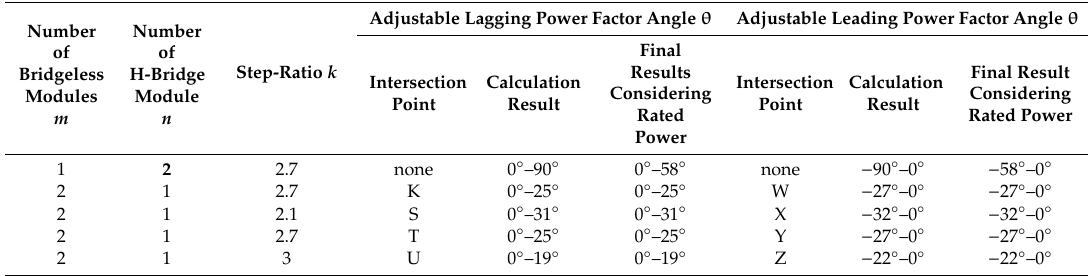
Figure 5. AC-side voltage of the n H-bridge modules U ∗ versus power factor angle θ ( a )with the various number of bridgeless modules m and the various number of H-bridge modules n under the same step-up ratio k in lagging power factor operation; ( b ) with various step-up ratio k under the same number of bridgeless modules m and H-bridge modules n in lagging power factor operation; ( c ) with the various number of bridgeless modules m and the various number of H-bridge modules n under the same step-up ratio k in leading power factor operation; ( d ) with various step-up ratio k under the same number of bridgeless modules m and H-bridge modules n in leading power factor operation. Table 3. Main parameters and calculated